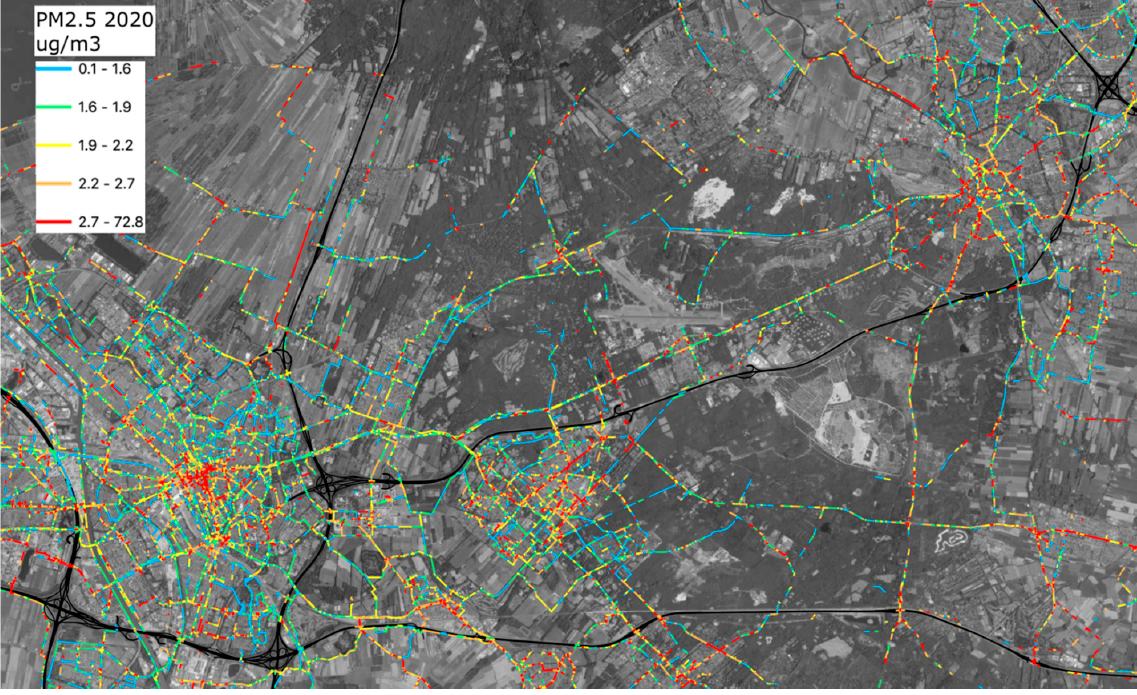
Figure 14. Average PM 2 . 5 concentration contributions due to local traffic between the cities of Utrecht (bottom, left) and Amersfoort (top, right). All concentrations in μ g/m 3 .